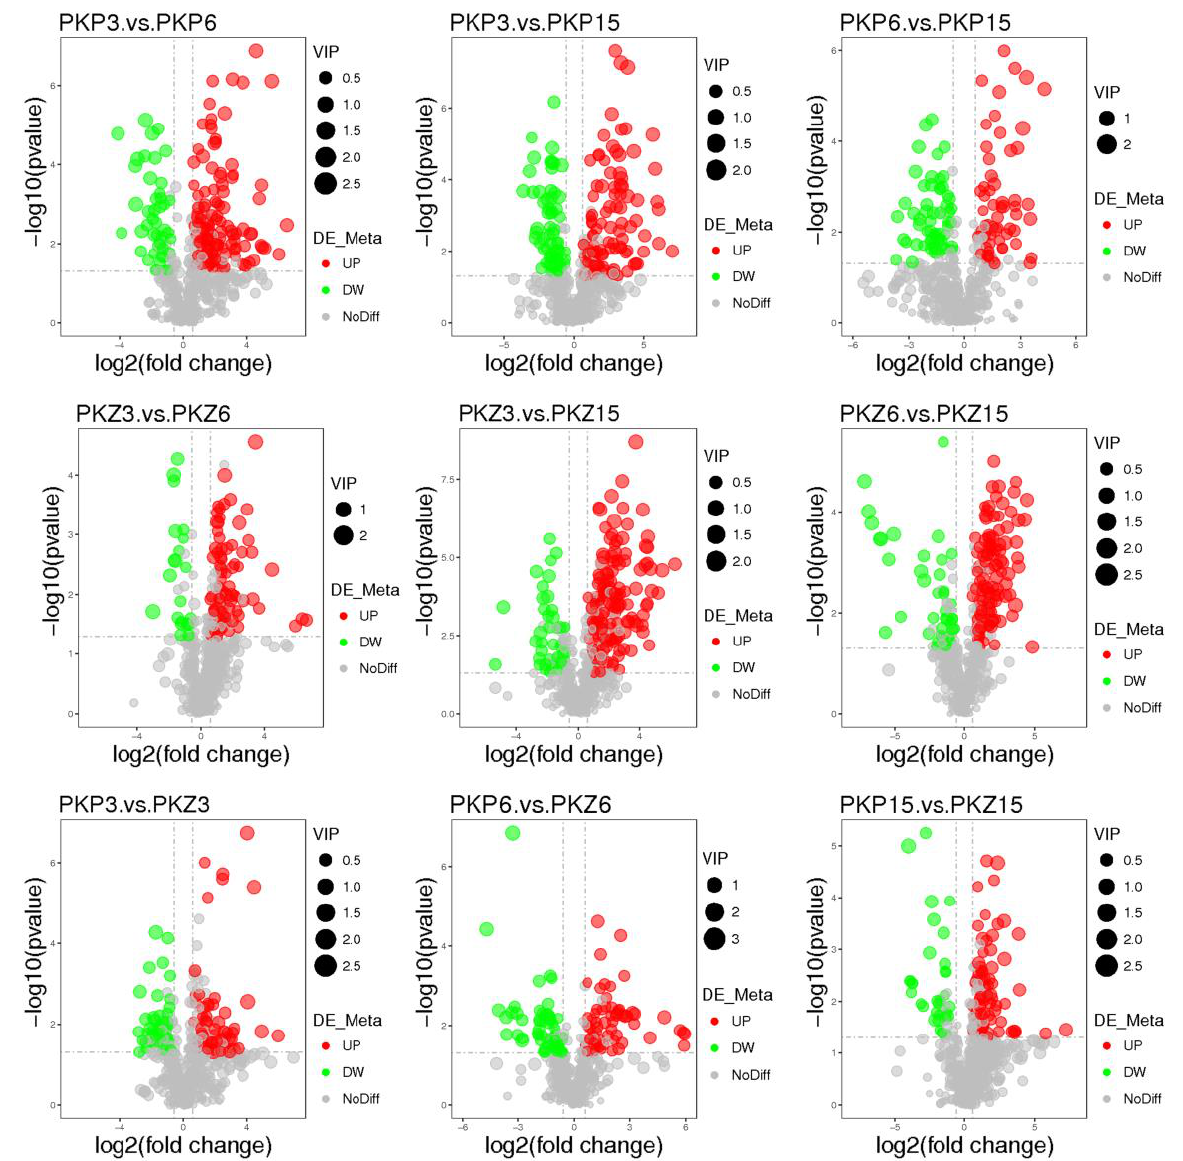
Figure 6. PLS-DA score plot of positive and negative ion modes for each comparison group (negative ion mode). PKP3-PKZ15 is the same as Table 1.